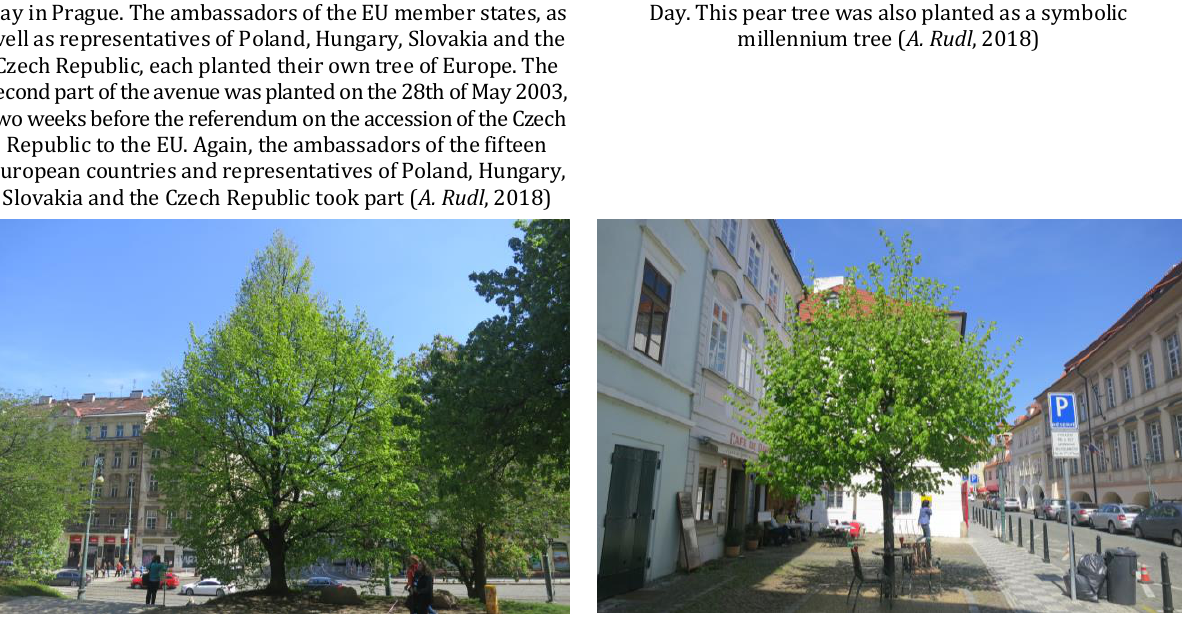
Fig. 6. An important message is held by the Lime Tree of Vaclav Havel (former Czech president), around which a "Vaclav Havel Bench" was established on the 1st of May 2014 to commemorate the 10th anniversary of the accession of the Czech Republic to the EU ( A. Rudl ,